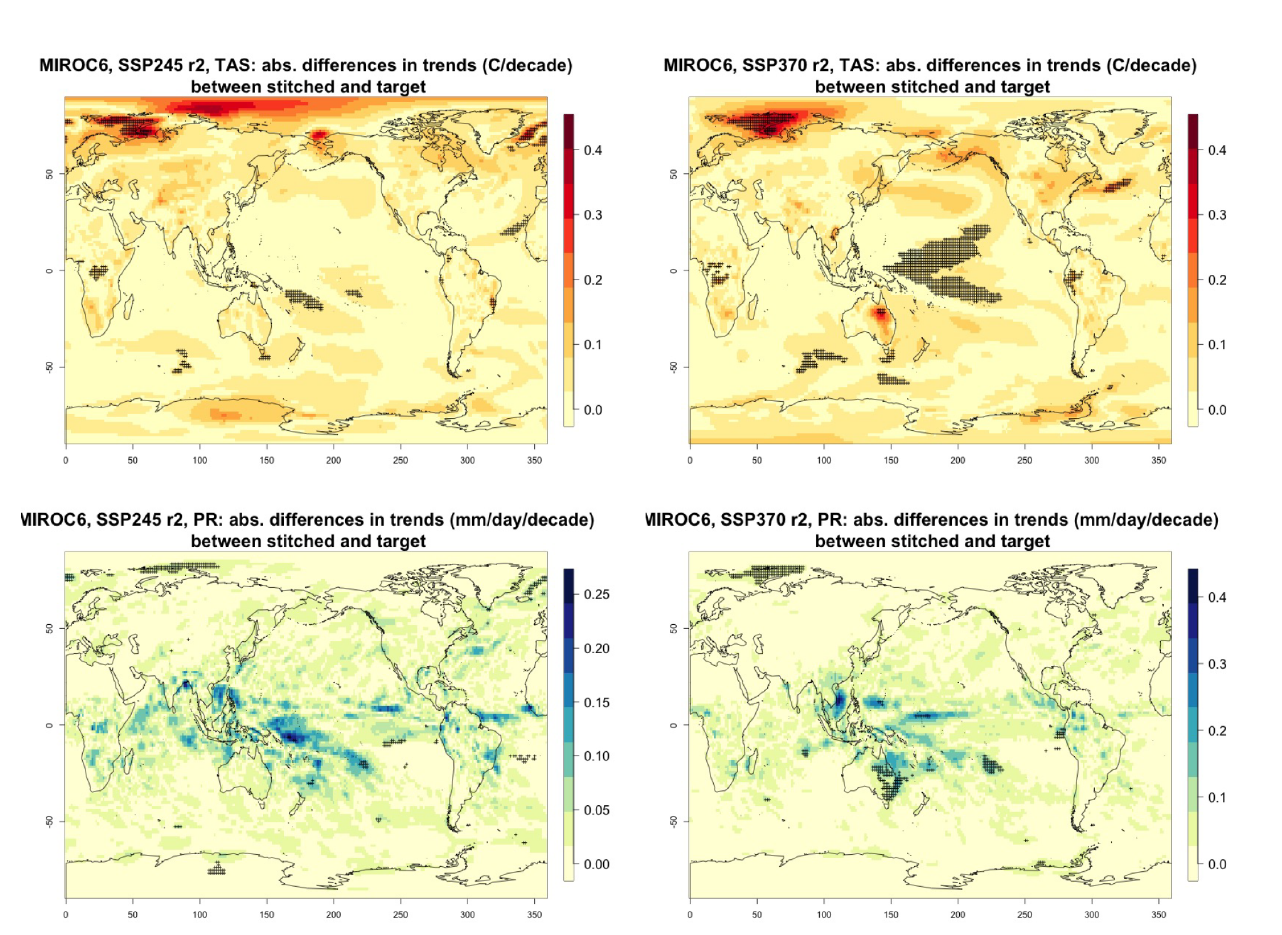
Figure C2. Absolute difference in decadal trends of temperature (TAS) and precipitation (PR) between stitched and target realizations. The value of the difference is expressed by the color scale, and we marked as significant with black crosses those locations where the 95% confidence intervals of the trends computed from target and stitched time series do not overlap, indicating statistically significant differences. Emulation of MIROC6, monthly time series over 2015–2100, for SSP2-4.5 and SSP3-7.0. Second realization.